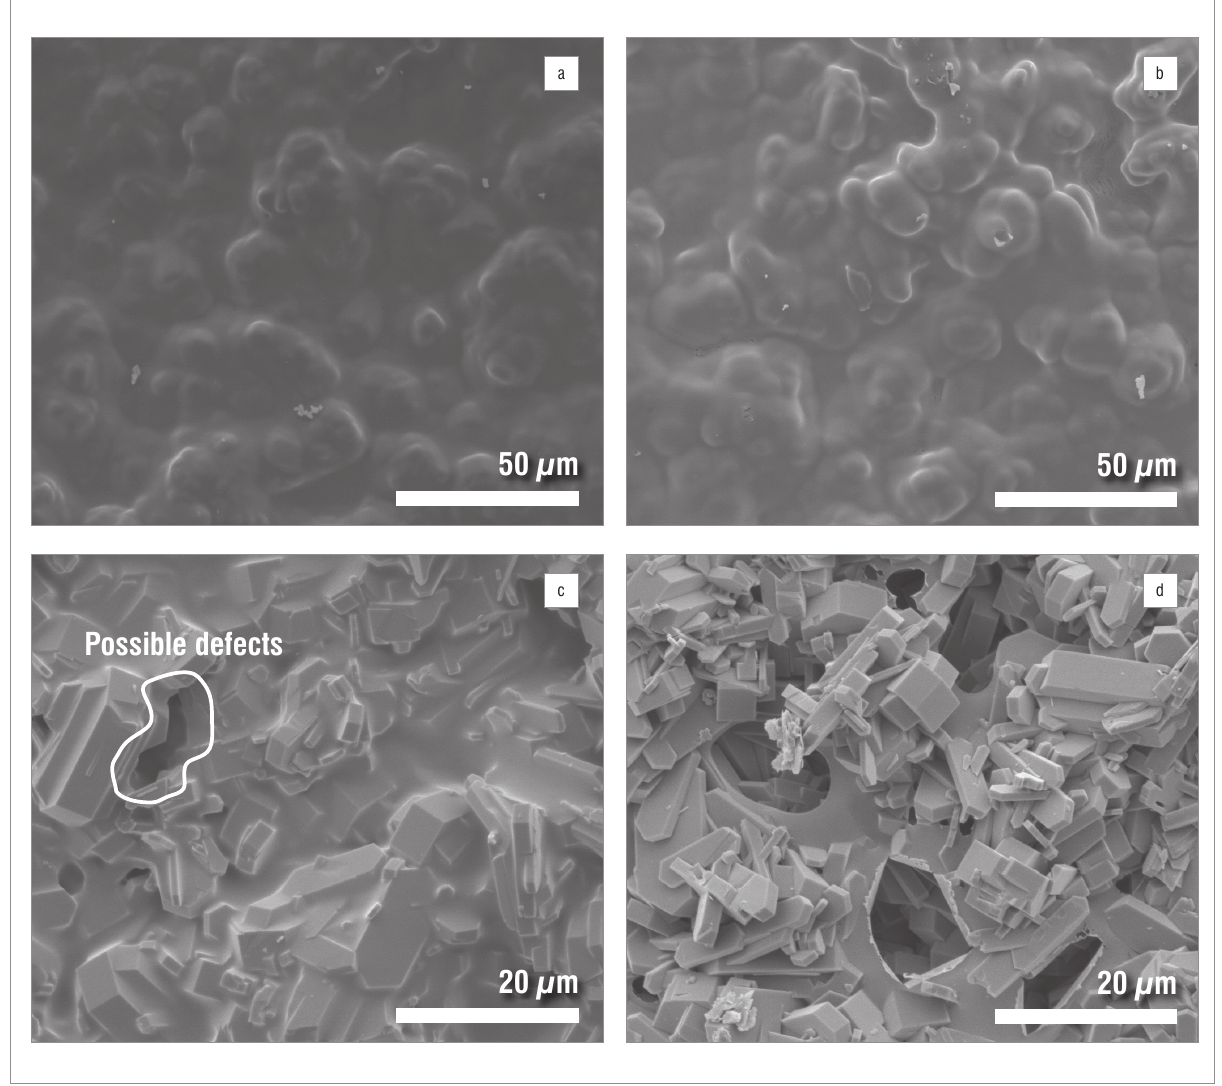
Figure 8: Scanning electron micrographs of the top views of the Teflon AF 2400 coatings over the mordenite framework inverted (MFI) membrane after 1-h treatments at temperatures of (a) 100 °C, (b) 150 °C, (c) 200 °C and (d) 300